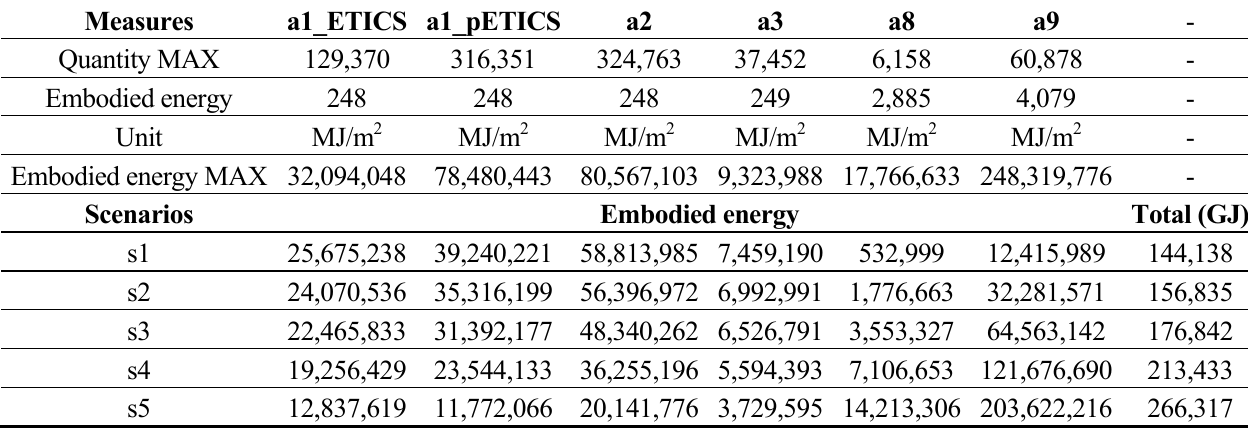
Table 8. Embodied energy in each measure and in each strategy.